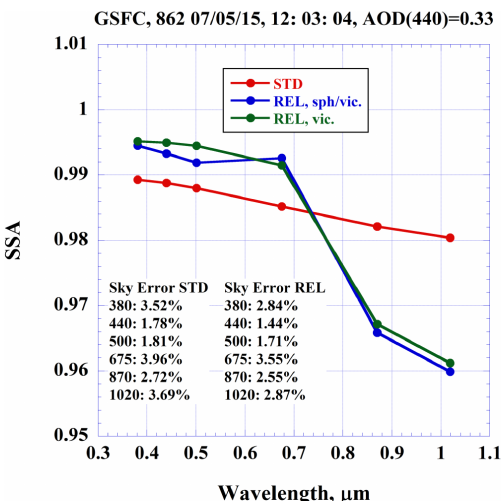
Figure 9. Same as Fig. 7a with the addition of SSA retrieved from vicariously calibrated sky radiances, depicted by “REL, vic”. The abbreviation “REL, sph./vic.” refers to SSA retrieved by invert- ing sky radiances calibrated using the integrated sphere at all the channels except 380nm, which was calibrated using the vicarious